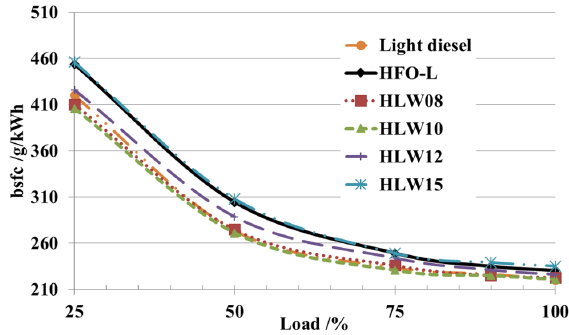
Figure 12. Comparison of brake specific fuel consumption (BSFC).